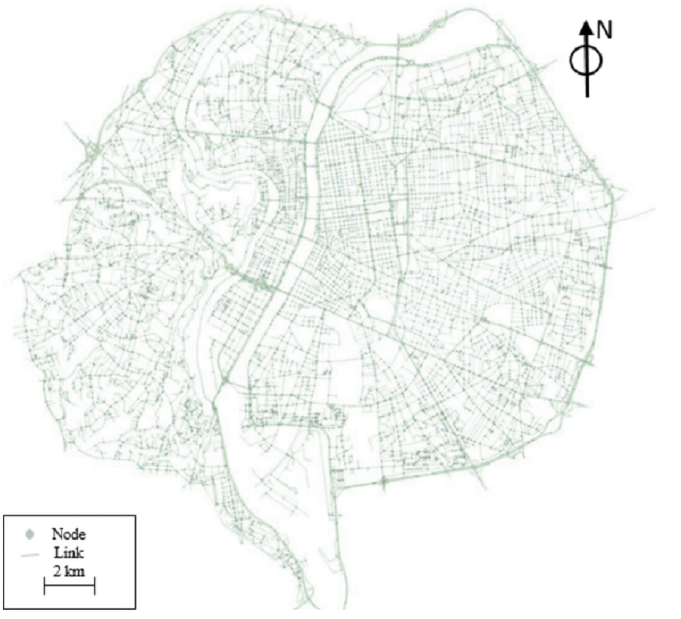
Fig 4. Network of Lyon.